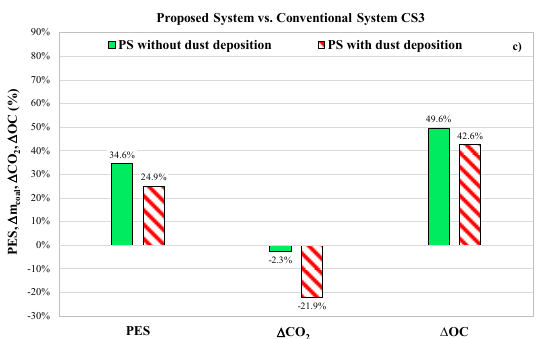
Figure 15. Seasonal values of primary energy saving (PES), ∆ CO 2 , ∆ m coal and ∆ OC associated with the proposed system (with and without dust deposition effects) when compared with the conventional system CS1 ( a ), the conventional system CS2 ( b ) and the conventional system CS3 ( c ).